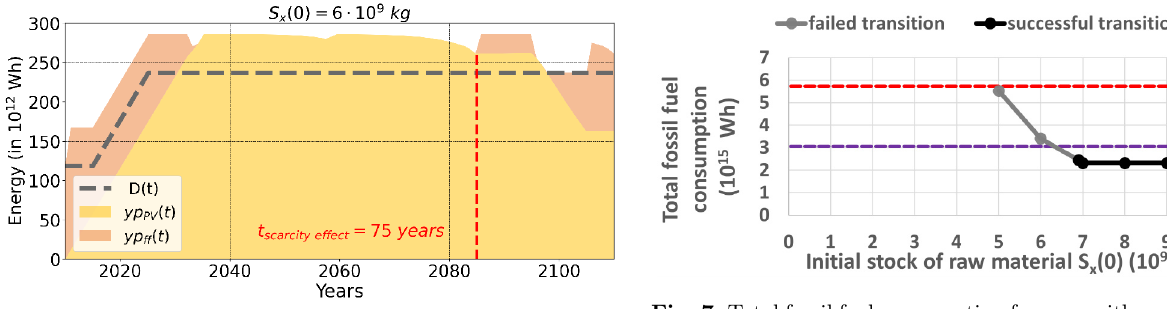
Fig. 5. Energy mix of France following the scenario B with S x (0) = 6 billion kilograms and t f = 100 years. Highlighting the scarcity effect on the PV production after 75 years.